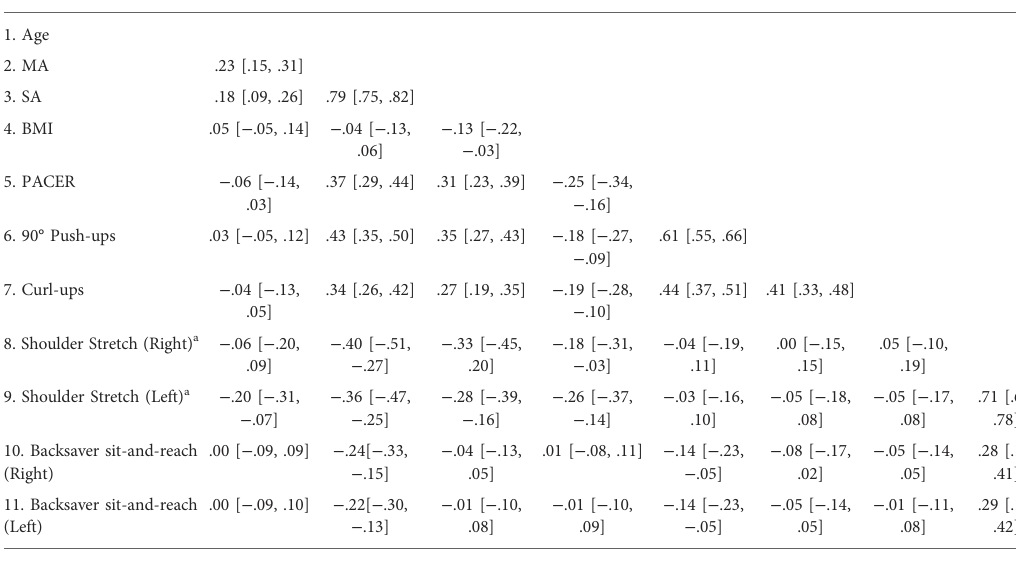
TABLE 9 Pearson and polyserial bivariate correlation matrix for PPLA-O